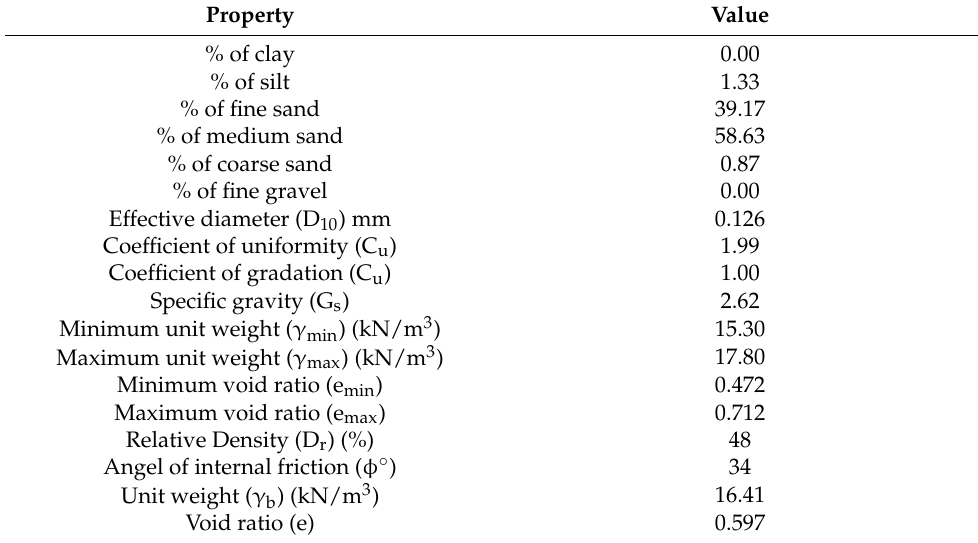
Figure 1. Sand filled tank and testing loading frame with base. Table 1. Soil model properties.